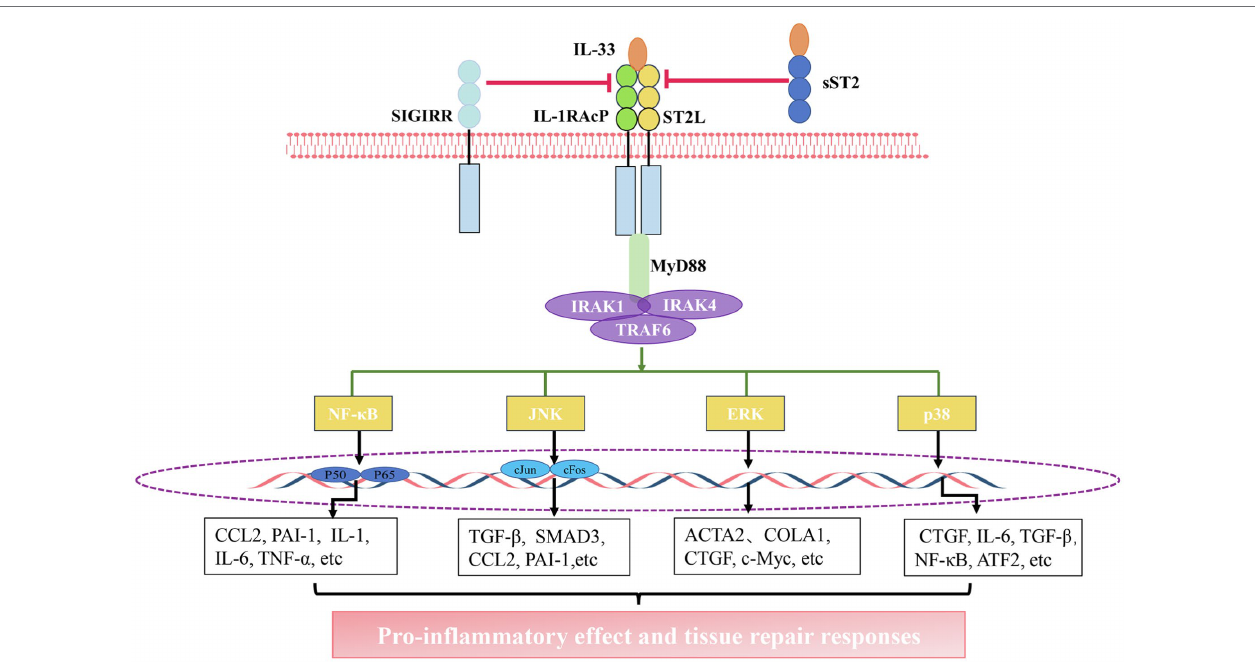
FIGURE 1 | The interleukin-33 (IL-33)/suppression of tumorigenicity 2 (ST2) pathway. Activation of the IL-33/ST2 pathway: IL-33 binds to a receptor complex composed of ST2L and interleukin 1 receptor accessory protein (IL-1RACP) on the cell membrane. The interaction between the C-terminal domain of this receptor complex promotes the recruitment of myeloid differentiation primary response 88 (MyD88), IL-1 receptor-associated kinase 1 (IRAK1), IRAK4, and tumor necrosis factor receptor (TNFR)-associated factor 6 (TRAF6), thus leading to the activation of nuclear factor kappa light chain enhancer of activated B cells (NF- κ B), c-Jun N-terminal kinase (JNK), extracellular signal-regulated kinase (ERK), and P38 pathways. The activation of these pathways facilitates the gene expression of chemokines and growth factors. The inhibition of the IL-33/ST2 pathway: soluble ST2 (sST2) acts as a decoy receptor for IL-33 to block the binding of IL-33 to the receptor. single immunoglobulin IL1-related receptor (SIGIRR) can destroy ST2L/IL1RAcP